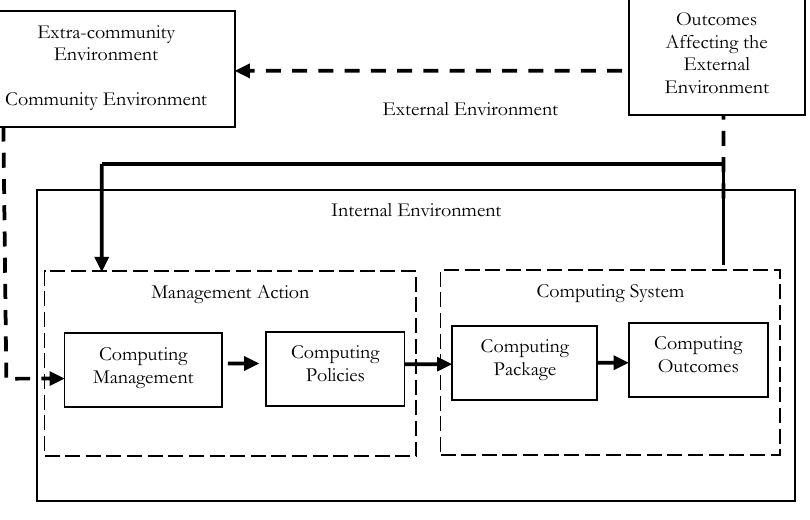
Figure 2: Process model of computing change (Kraemer et al.,